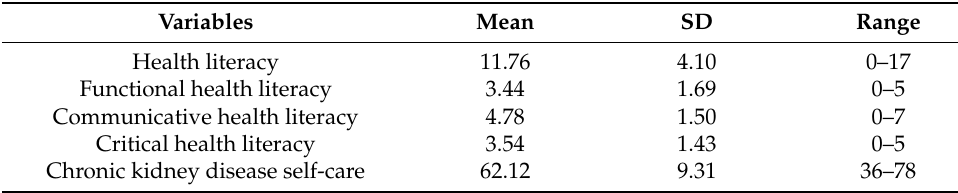
Table 2. Descriptive results of subscales of health literacy and CKD